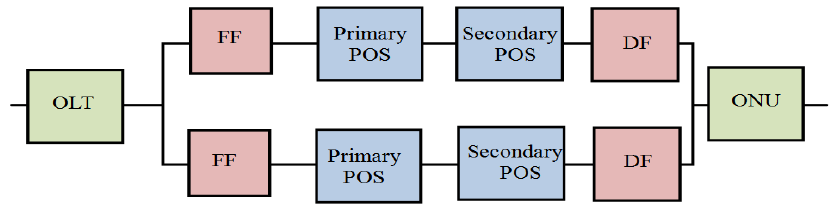
Figure 11. Reliability block diagram for (distributed fiber) DF protection architecture.